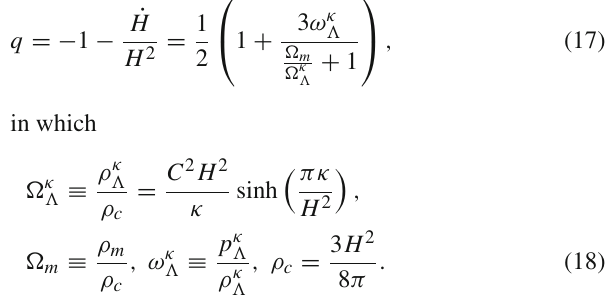
respectively, where dot denotes derivative with respect